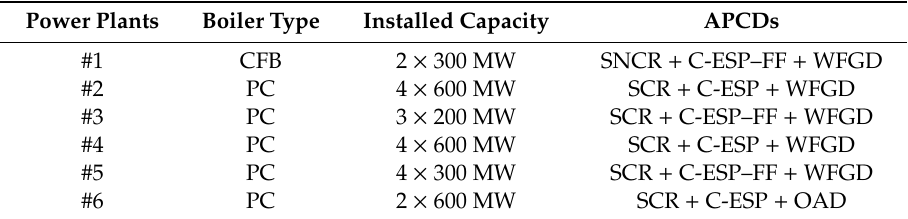
Figure 1. ( a ) Distribution and formation ages of coal in China (modified from Dai and Finkelman [30]), and ( b ) the locations of six coal-fired power plants (CFPPs) in this study and Cr concentration in Guizhou’s coal (internal unpublished data). Table 1. Information regarding the six CFPPs surveyed in the present study.